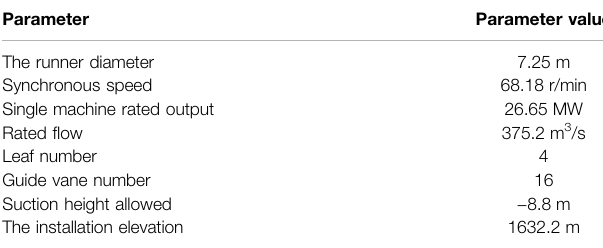
TABLE 1 | Main technical parameters of the bulb tubular